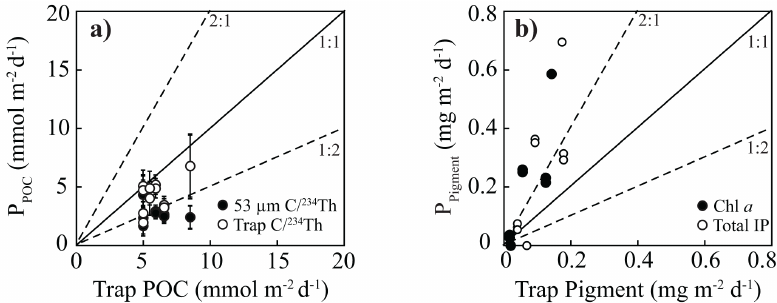
Figure 11. (a) Comparison of sediment trap POC fluxes and 234 Th-derived POC fluxes, and (b) a comparison of sediment trap Chl a and total indicator pigment fluxes and 234 Th-derived pigments fluxes at OSP during June 2011 and June 2012.